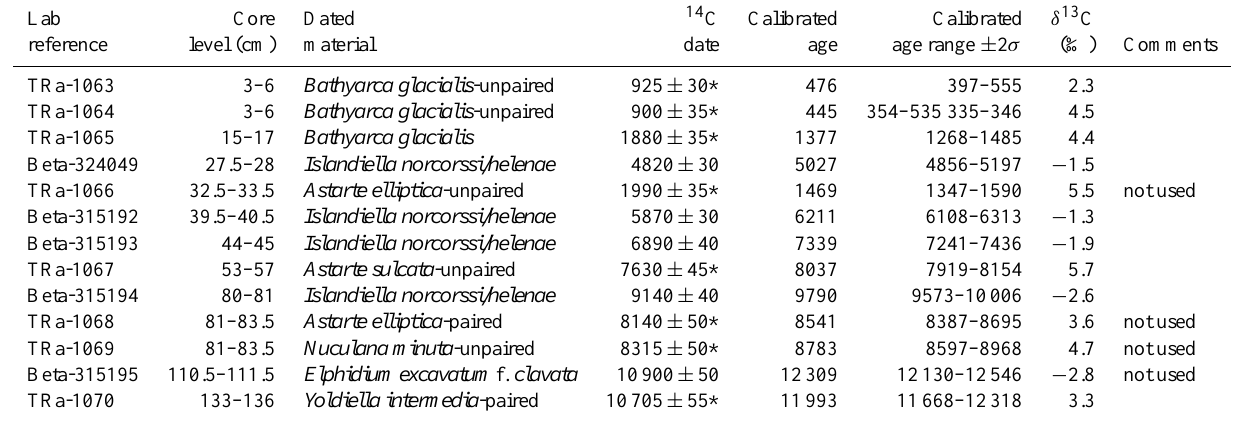
Table 1. AMS 14 C dates and calibrated dates for core JM09-KA11-GC. The dates were dated at TRa: Radiocarbon Laboratory in Trondheim, Norway, and Uppsala, Sweden, and Beta: Beta Analytic Inc. in Miami, Florida, US. Radiocarbon ages are calibrated in the Calib 7.0 program (Stuiver et al., 2005) using the Marine13 calibration curve (Reimer et al., 2013). A standard reservoir correction of 400yr and regional 1 R value of 67 ± 34 (Mangerud and Gulliksen, 1975) was used. Dates marked with * are from Rüther et al.